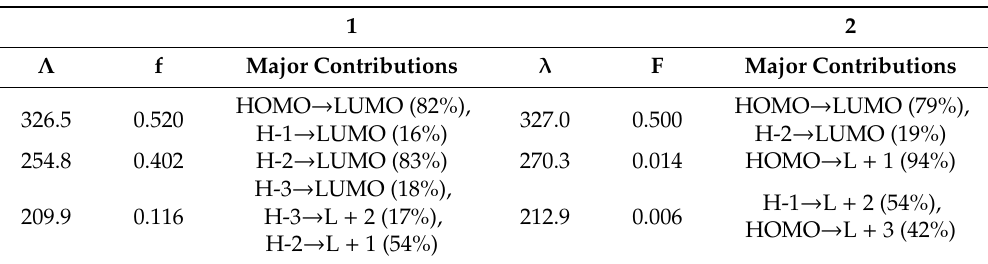
Table 4. The calculated electronic transition bands ( λ in nm) and their oscillator strength (f) of the studied compounds 1 and 2